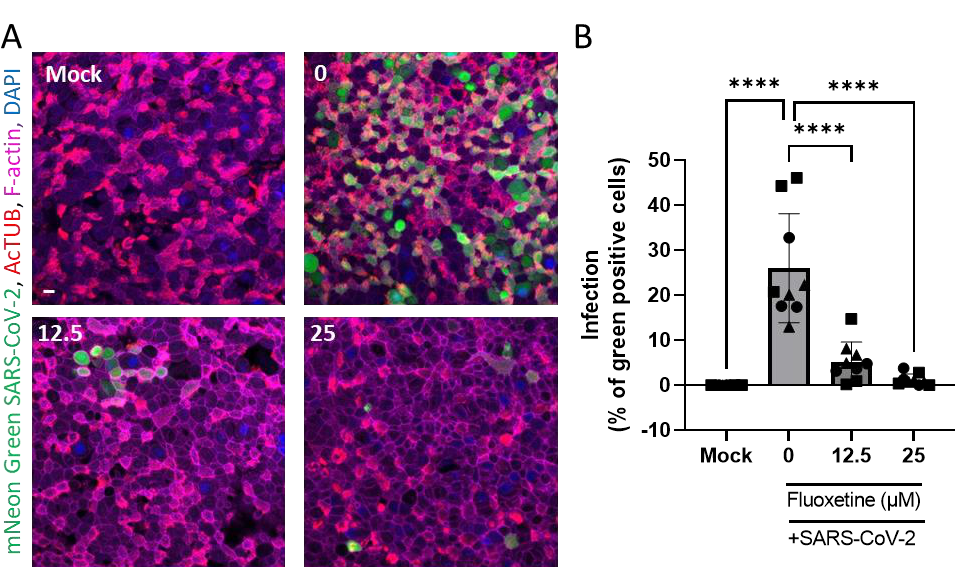
Figure 4. Fluoxetine inhibits SARS-CoV-2 infection of 2D human airway cells. ( A ) Representative images of immunofluorescent stainings of mNeon Green SARS-CoV-2 infected airway cultures. Acetylated tubulin (AcTUB, red) stains cell ciliates, phalloidin-coupled Alexa Fluor 647 stains F- actin (purple) and DAPI stains nuclei (blue). Scale bar = 10 µm. ( B ) Live virus titre measured on apical washes 72 h after infection with mNeon Green SARS-Cov-2. Data from three independent experiments on two independent donors, expressed as mean ± SEM, **** p < 0.0001.